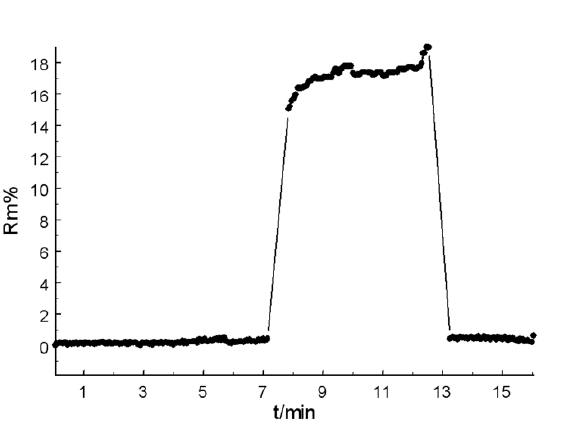
Fig. 8: Plot of the Rm% as a function of time obtained from the bubbling of CO2 into the cell suspension. The black arrow indicates the start of